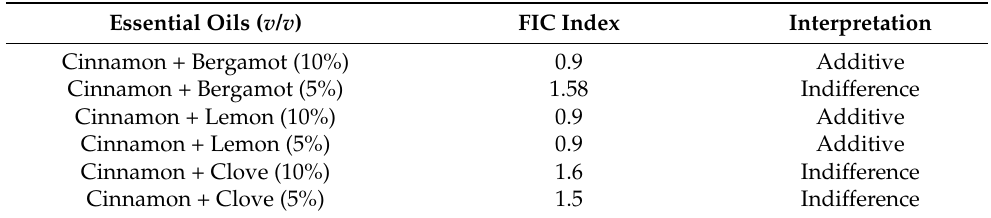
Table 4. FIC indices of EOs